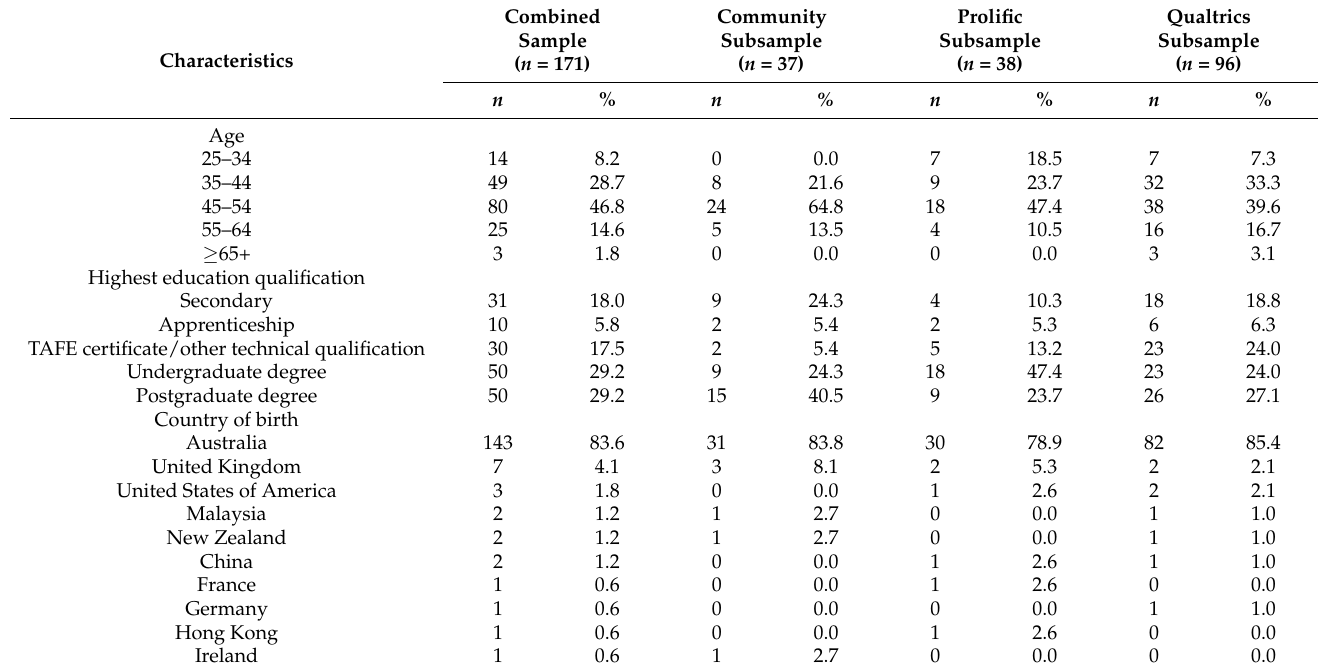
Table 1. Participant